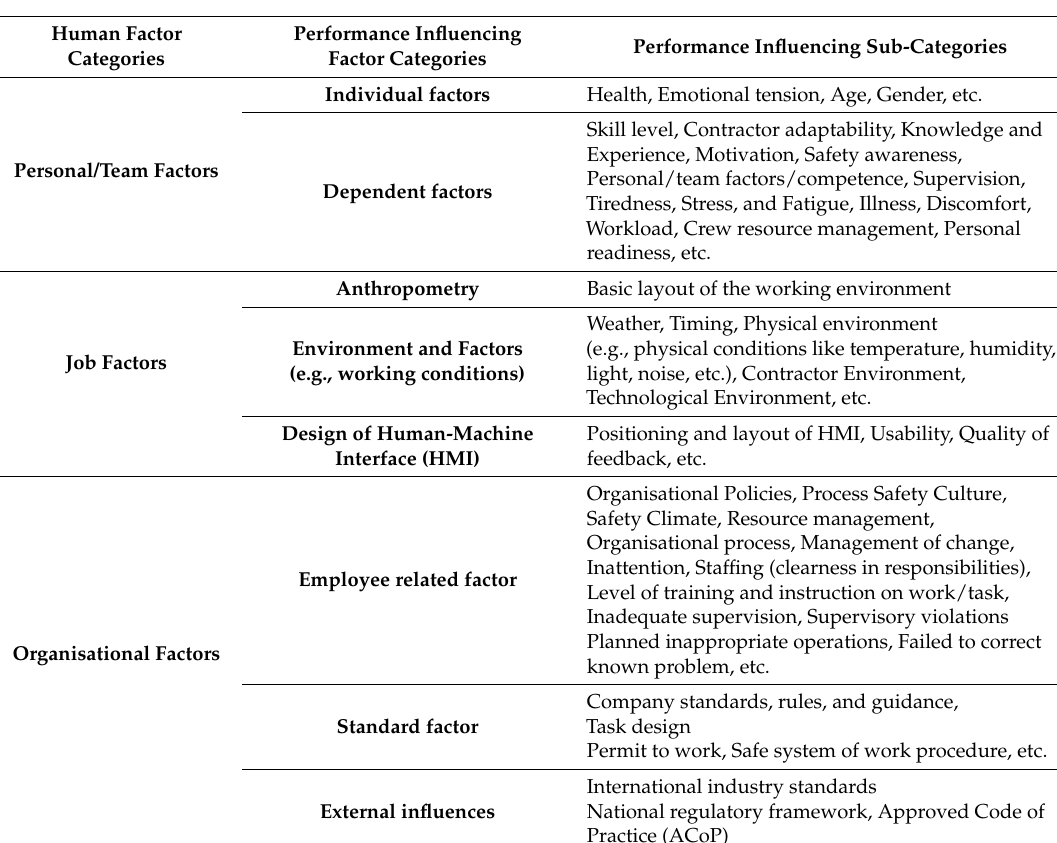
Table 8. Performance shaping factor/human factor